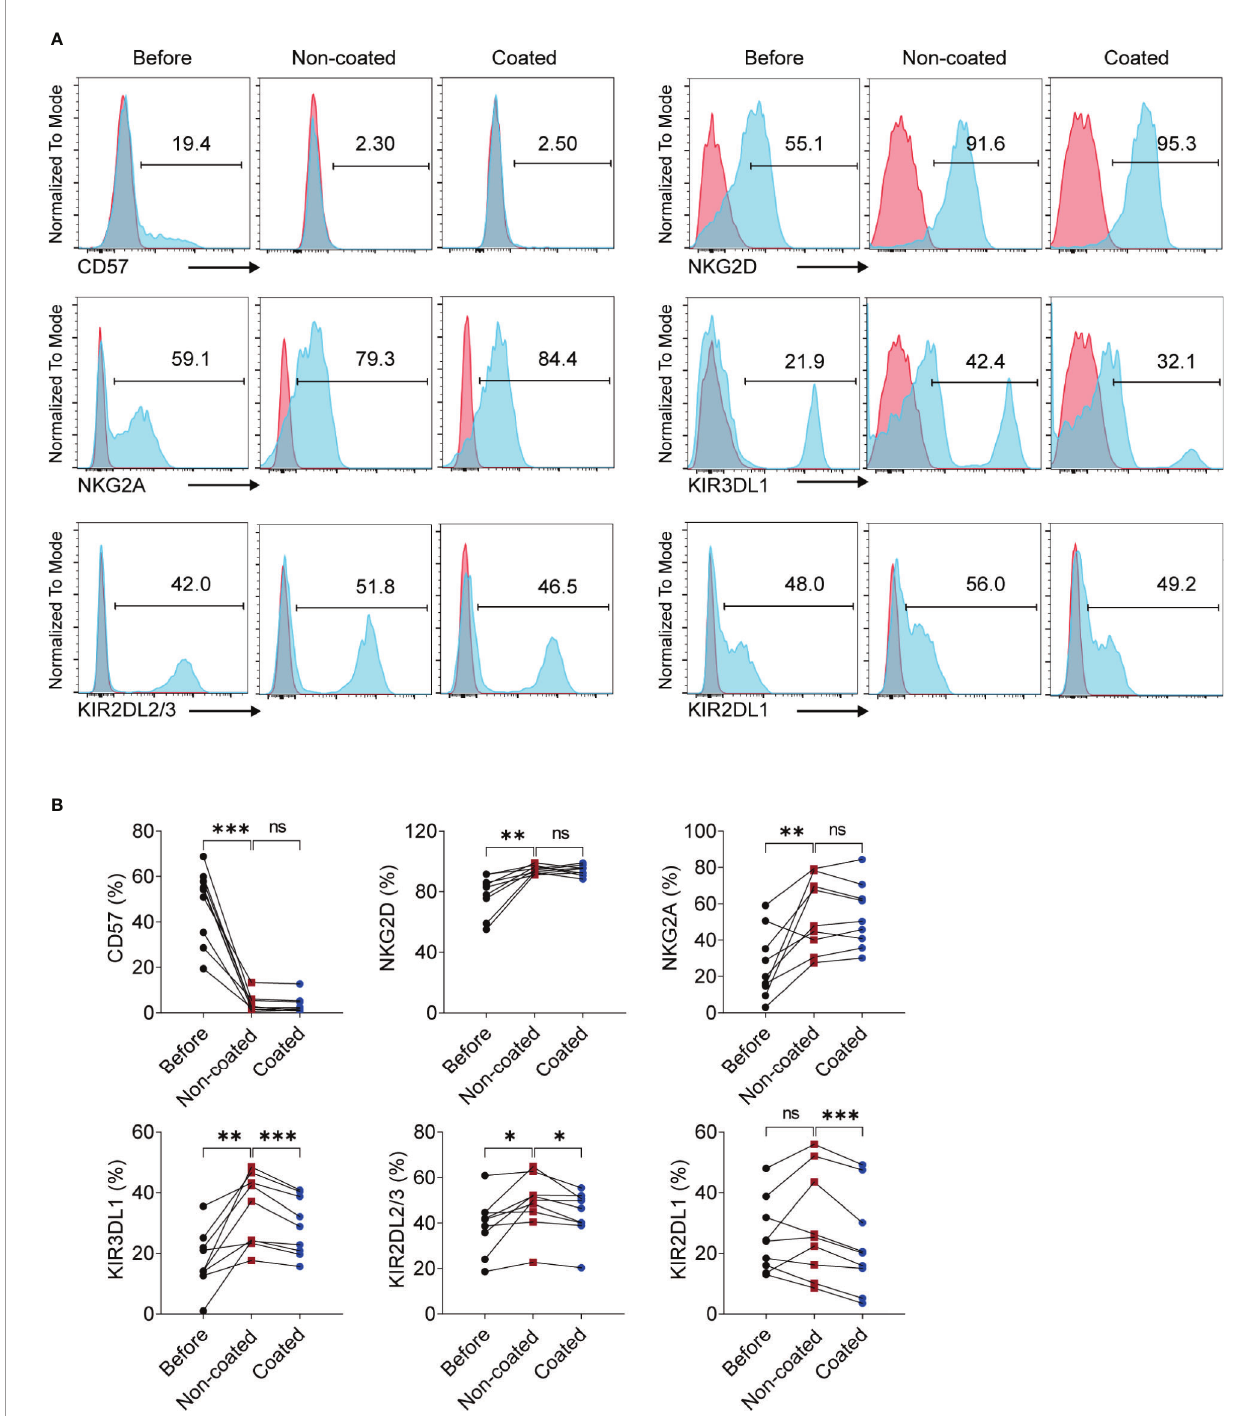
FIGURE 4 | NK cells expanded by non-coated rituximab have different phenotypes compared to naïve NK cells and NK cells induced by coated rituximab. (A) Representative fl ow cytometry analysis of the percentages of CD57, NKG2D, NKG2A, KIR3DL1, KIR2DL2/3, and KIR2DL1 on the NK cells before and after induction by coated and non-coated rituximab. (B) Graphs showing the percentages of CD57, NKG2D, NKG2A, KIR3DL1, KIR2DL2/3, and KIR2DL1 on the NK cells before induction and after induction by coated and non-coated rituximab. n = 9 donors, ns, not signi fi cant, p > 0.05, * p < 0.05, ** p < 0.01, *** p < 0.001; one-way